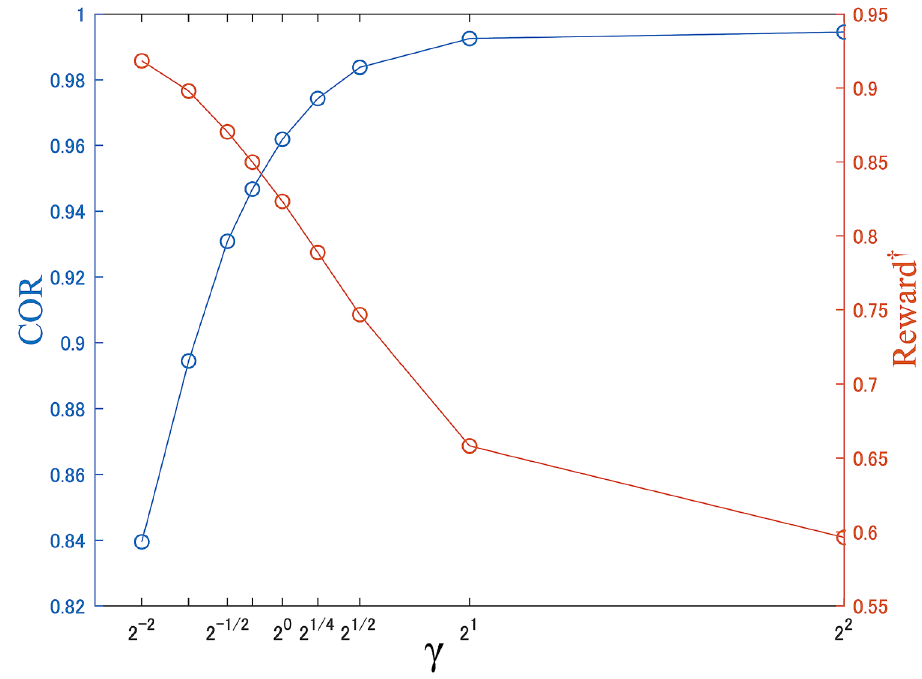
Figure 5. Parameter dependency of γ